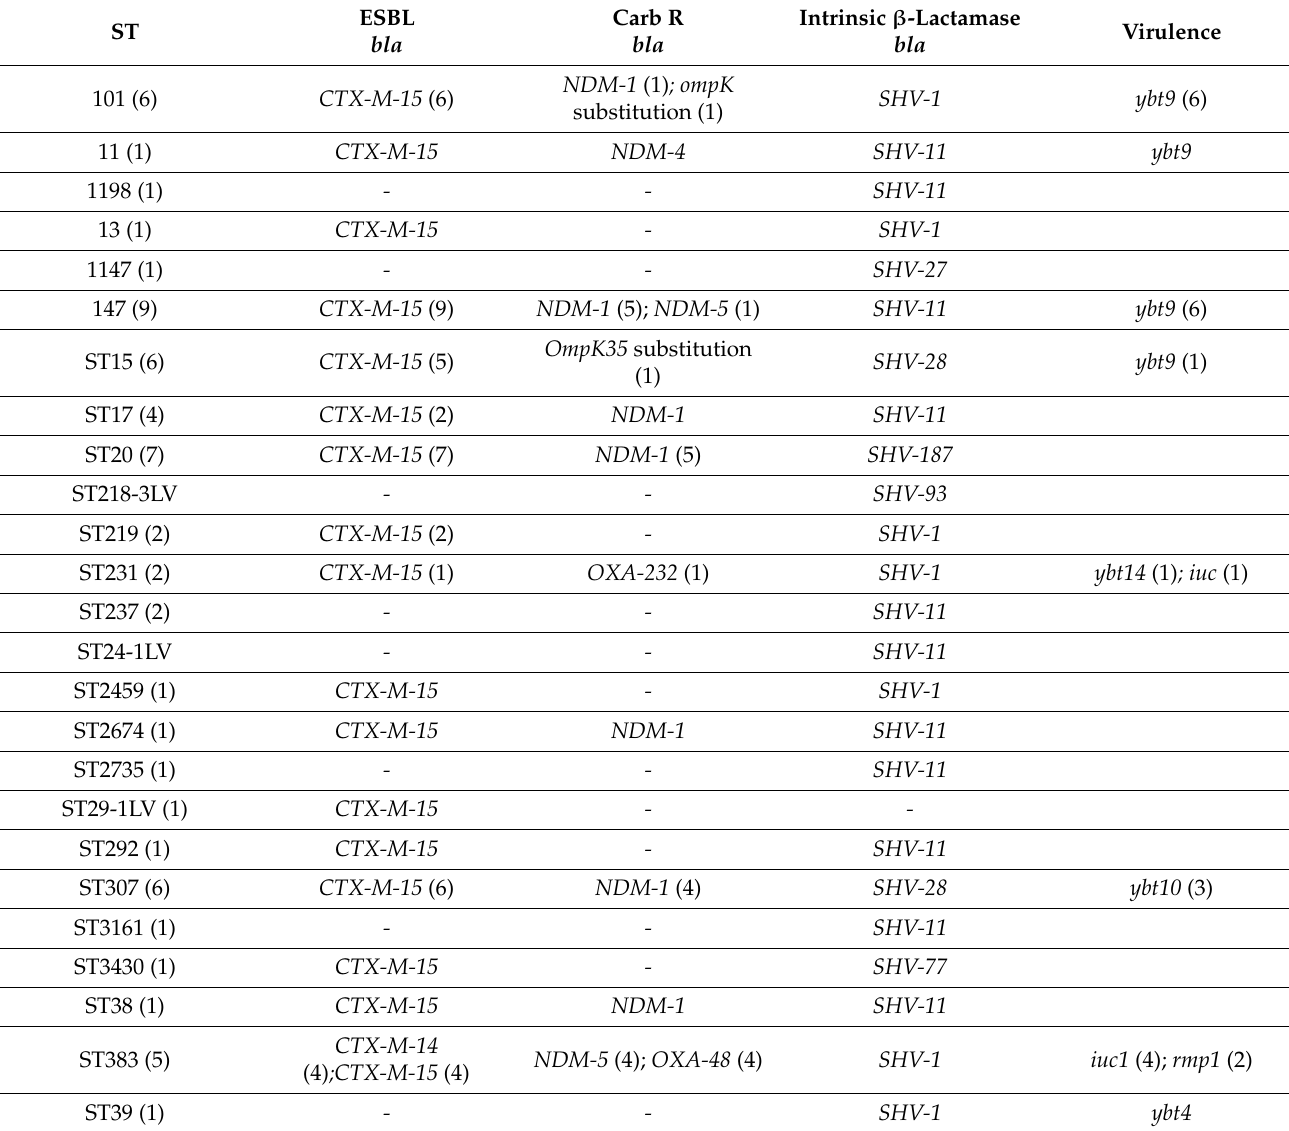
Table 2. Resistome and Virulence details of